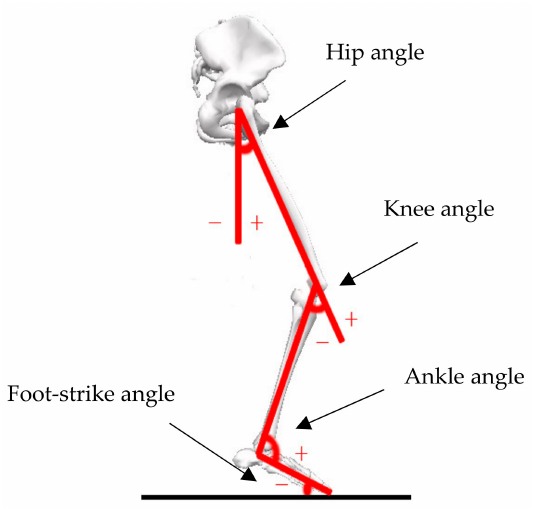
Figure 3. Angles of lower extremity